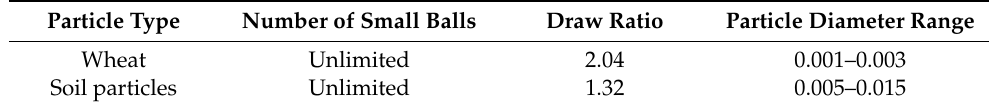
Table 1. Basic structural parameters of each particle.